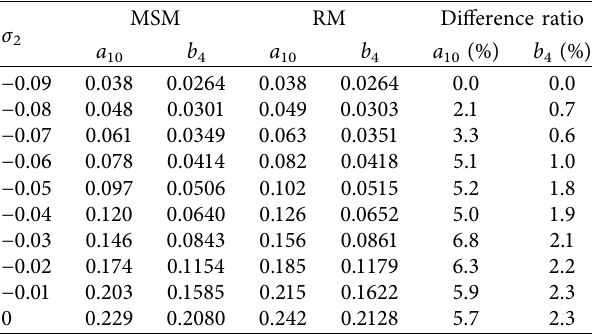
Table 3: Analytical solutions and numerical solutions of the cable- stayed shallow